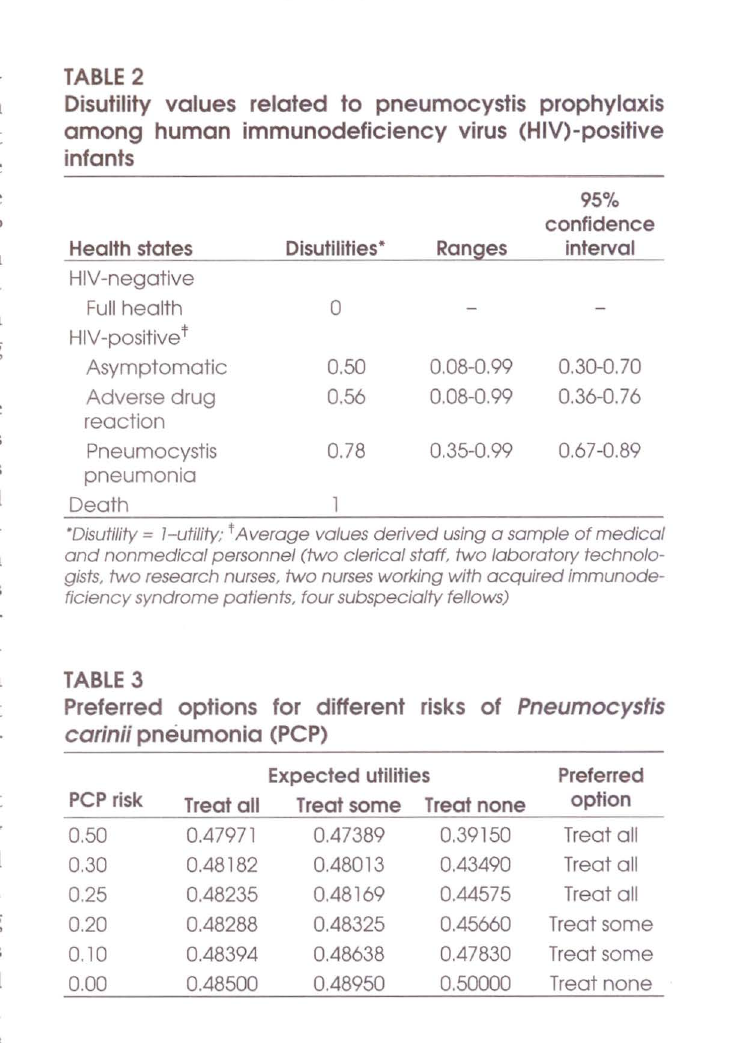
Preferred options for different risks of